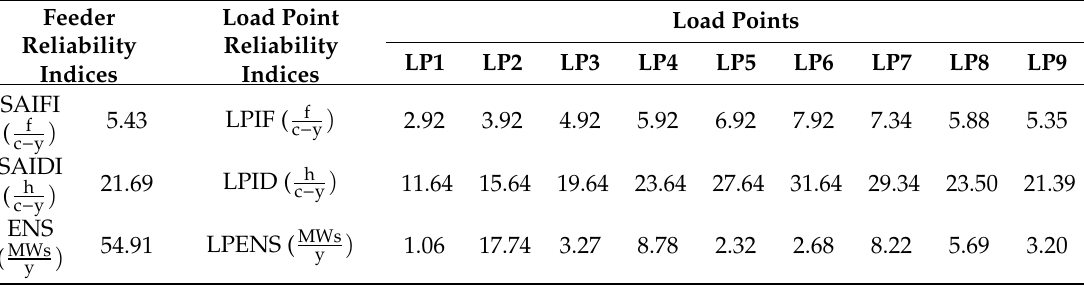
Table 3. Calculated reliability indices for Case-2.